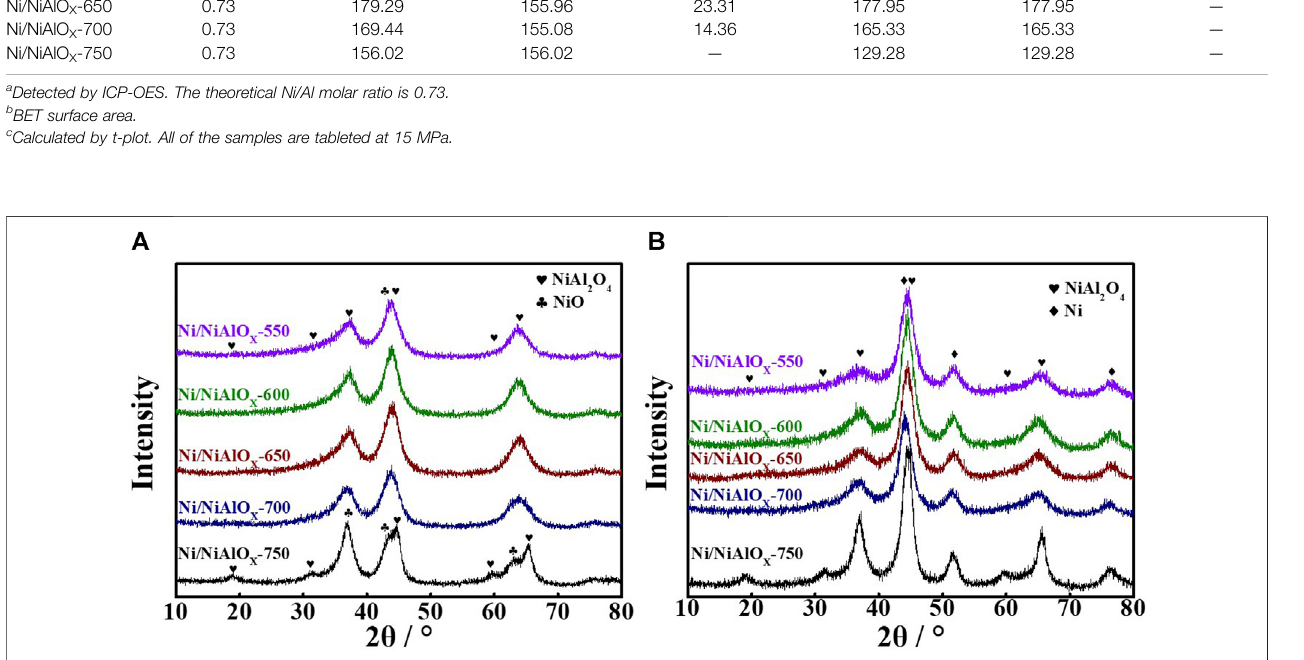
Frontiers in Chemistry |